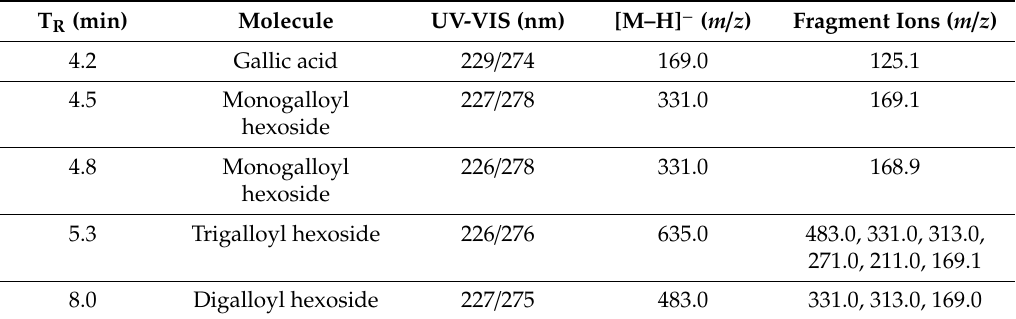
Table 1. Ultraviolet–visible (UV-VIS) absorption and mass spectroscopic data (negative ionization mode; [M–H] − ) of the identified polar phenolic compounds found in CSAT + ® by high performance liquid chromatography mass Spectrometry (HPLC-MS). T R = Retention time; sh =